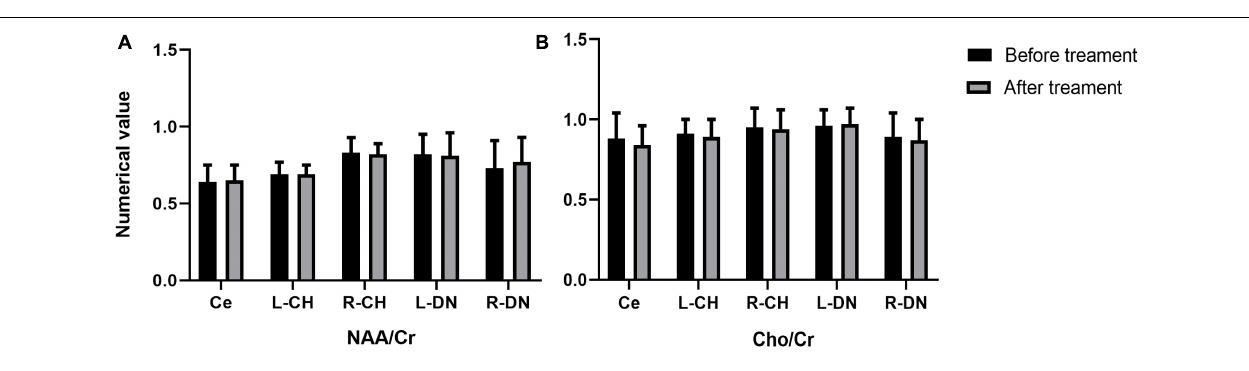
FIGURE 4 | Changes in the values of NAA / Cr (A) , and Cho / Cr (B) in cerebellar vermis, left and right cerebellar hemisphere, left and right dentate nucleus before and after treatment in the sham stimulation group (Ce representing the cerebellar vermis; L-CH representing the left cerebellar hemisphere; R-CH representing the right cerebellar hemisphere L-DN represents the left dentate nucleus; R-DN represents the right dentate